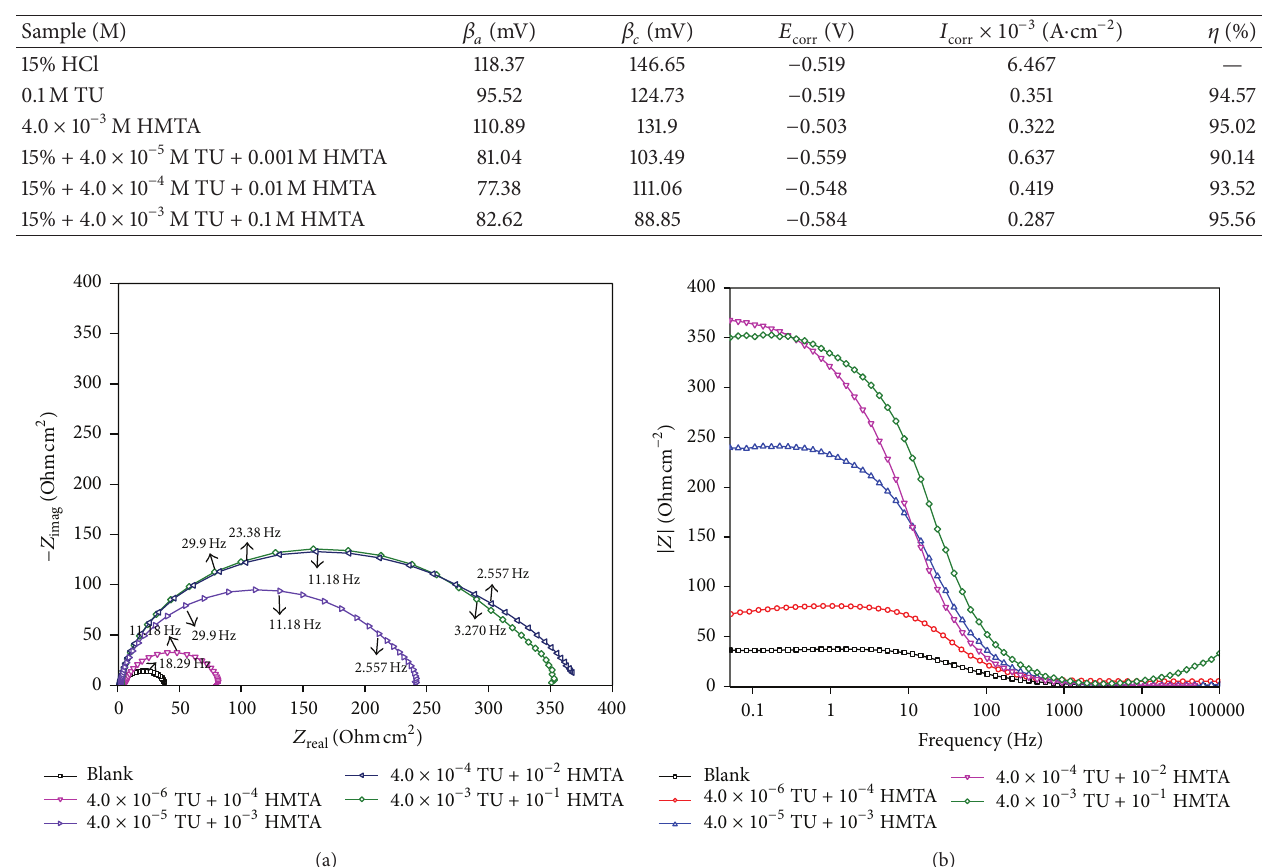
Table 2: Corrosion kinetics parameters of N80 in 15% HCl solution with different corrosion inhibitor.